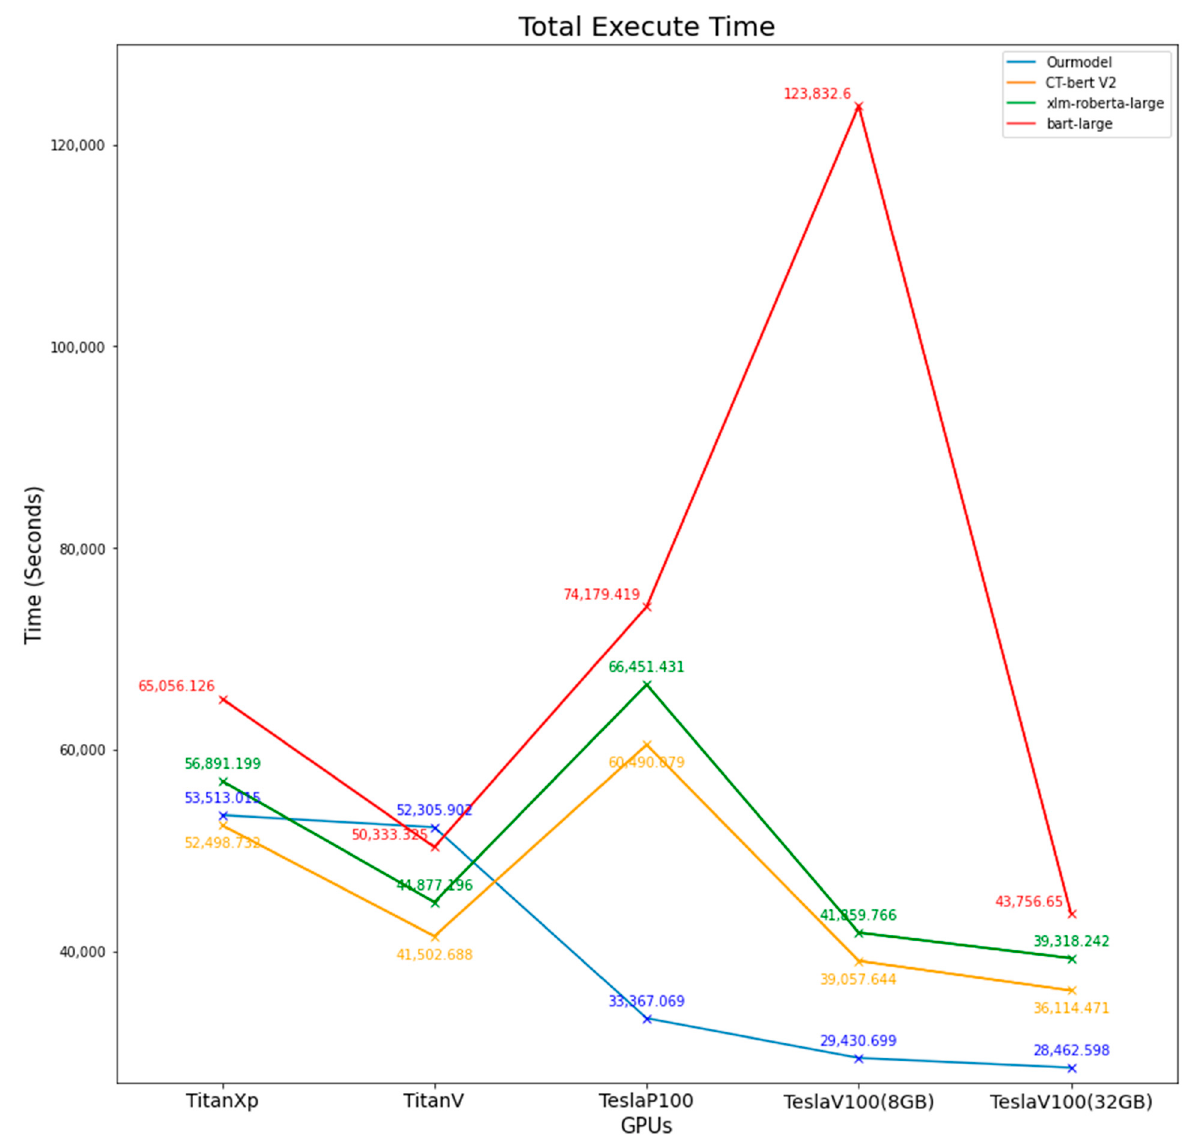
Figure 6. Comparison of total execution time from all models on different GPUs.